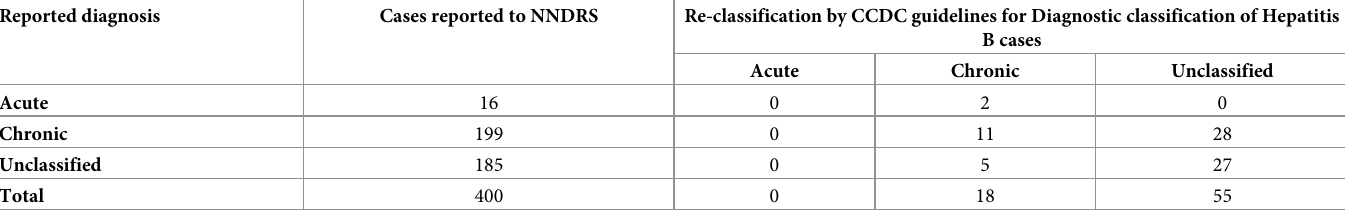
Table 1. Evaluation of 400 hepatitis B cases using standardized China CDC diagnostic criteria in Gannan from 2016 to 2017. Reported diagnosis Cases reported to NNDRS Re-classification by CCDC guidelines for Diagnostic classification of Hepatitis